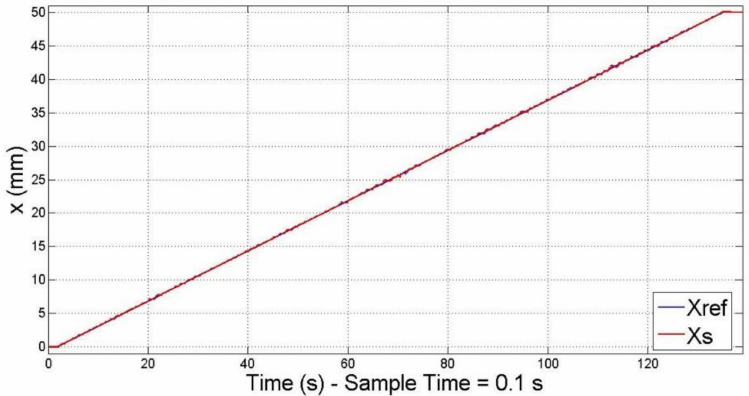
Figure 8. Experimental result: 50 mm travel range at constant